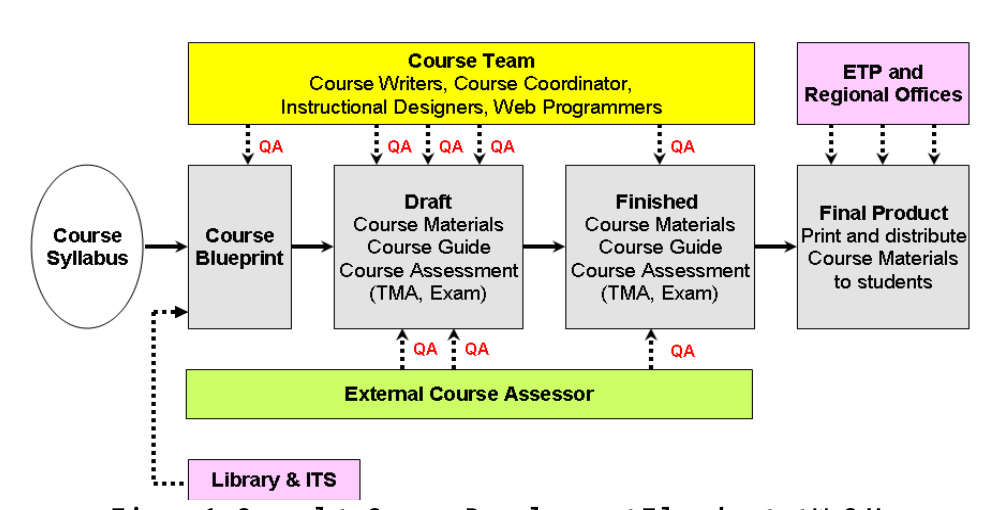
Figure 1: Complete Course Development Flowchart at